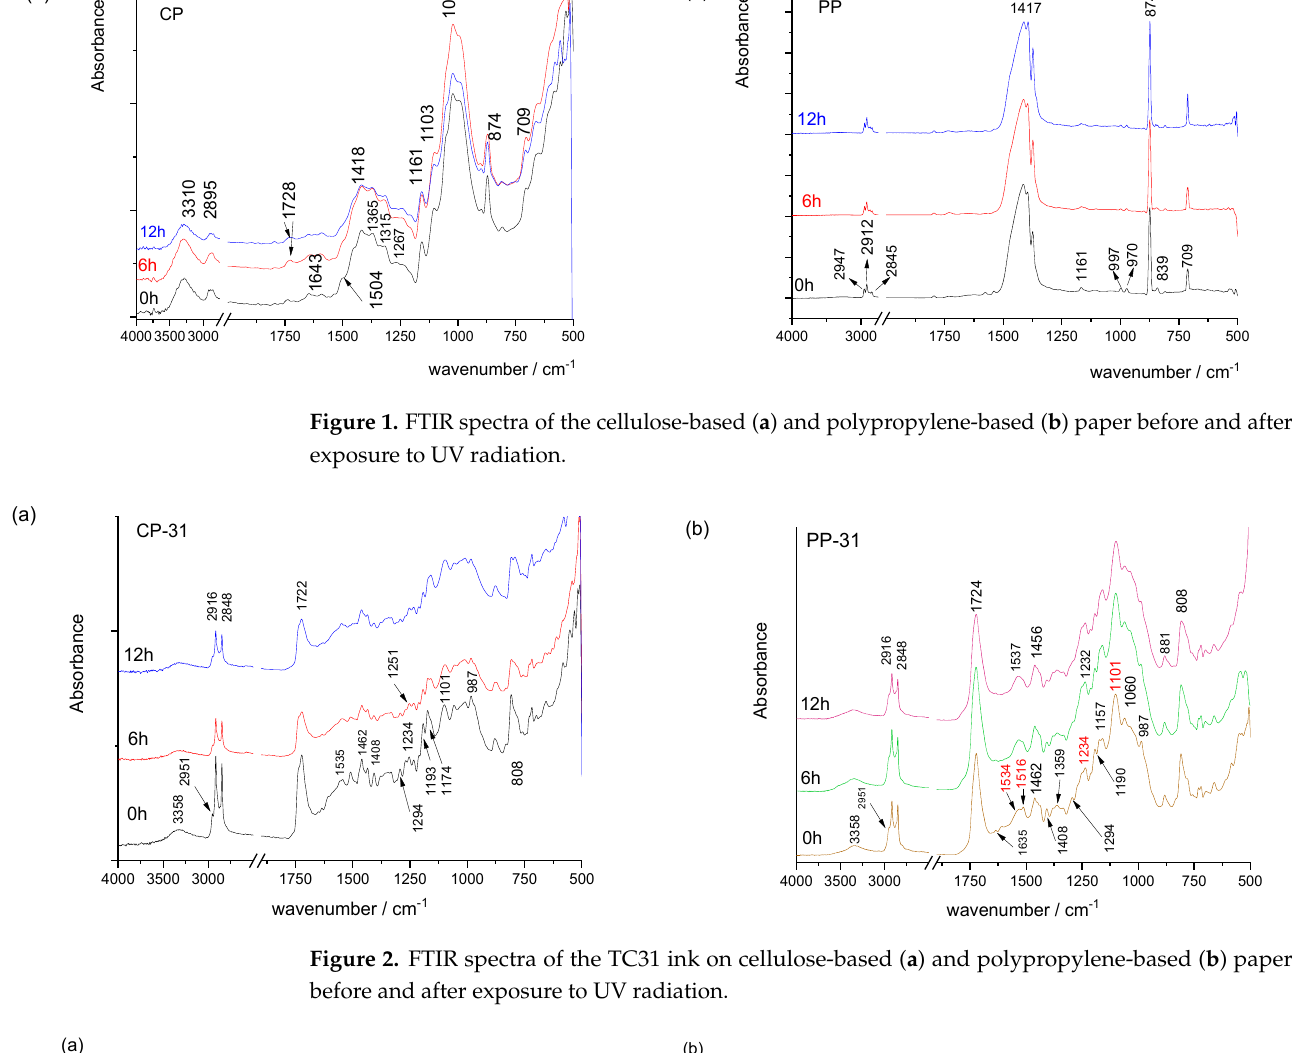
Figure 1. FTIR spectra of the cellulose-based ( a ) and polypropylene-based ( b ) paper before and after exposure to UV radiation.